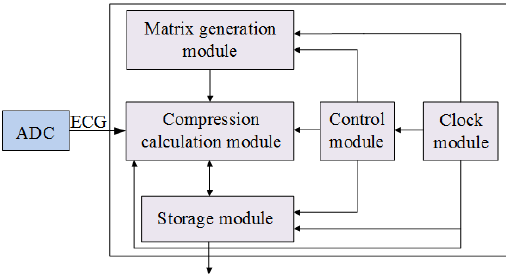
Figure 4. ECG signals processing circuit architecture.